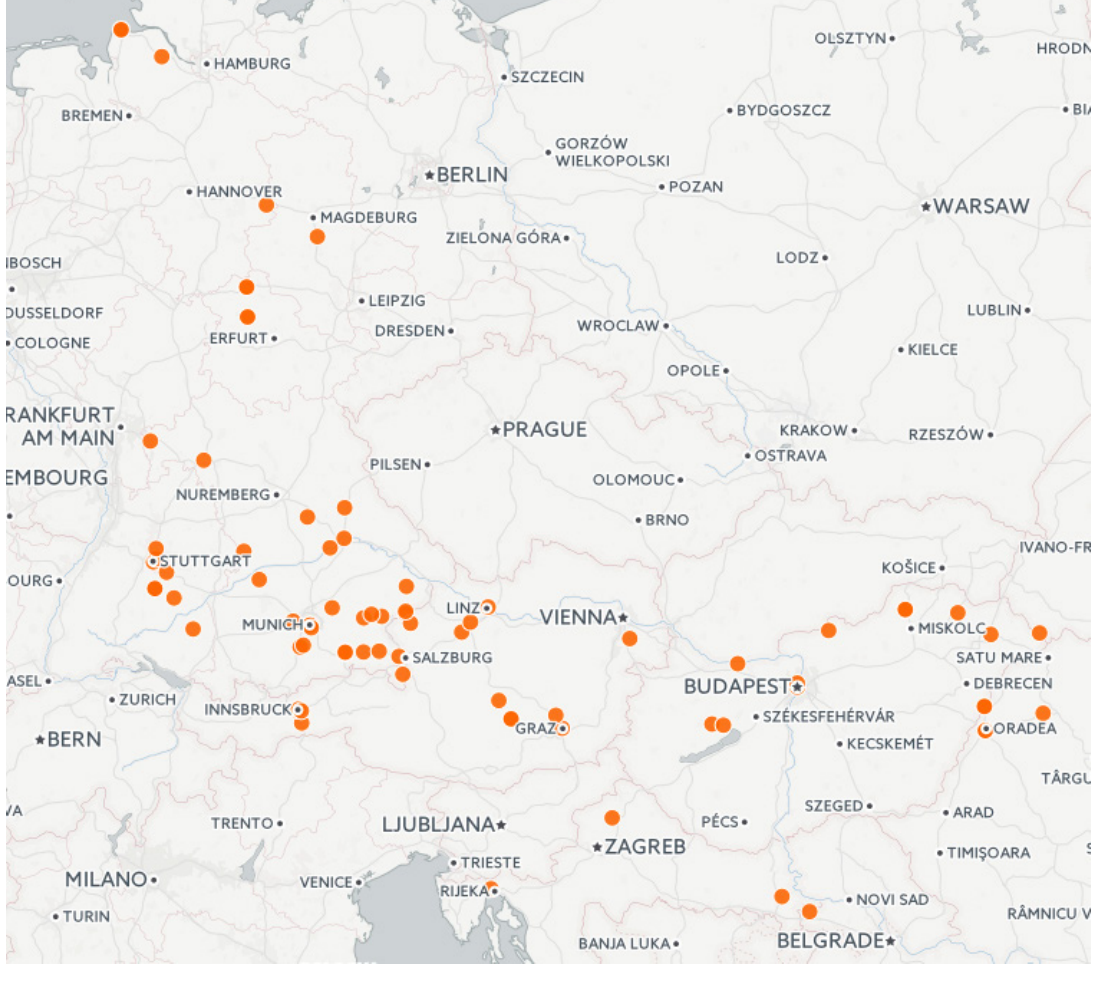
Figure 5. Find spot of all swords in the sample with known find locations. The map was generated using CartoDB